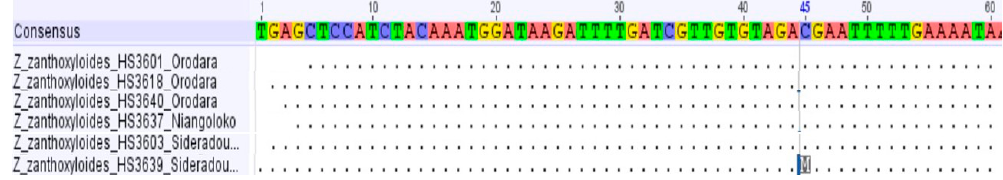
Figure 8. psbA-trnH alignment of Z. zanthoxyloides (partly).